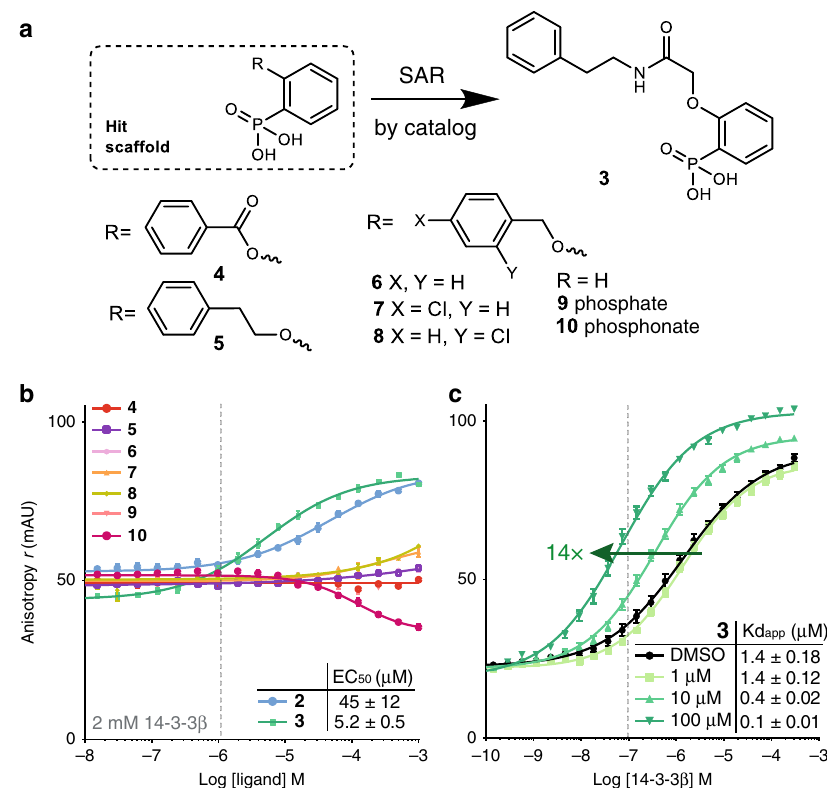
Fig. 2 Initial optimization via SAR-by-catalog of the hit scaffold 2-based series. a Eight derivatives of 2 were selected for molecular docking and in vitro testing. Titration curves of b ligands on 2 μ M 14-3-3 β and 100 nM fl uorescently-labeled ChREBP peptide, and c of 14-3-3 β on 100 nM fl uorescently-labeled ChREBP peptide in presence of increasing concentrations (1, 10, 100 μ M) of compound 3 . Data and error bars represent mean ± SEM, n = 3 replicates. Source data are provided as a Source data fi